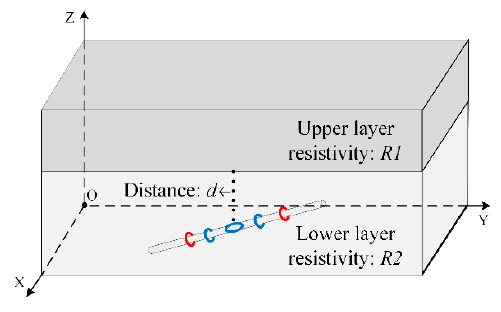
Figure 6. Two-layer formation model diagram.